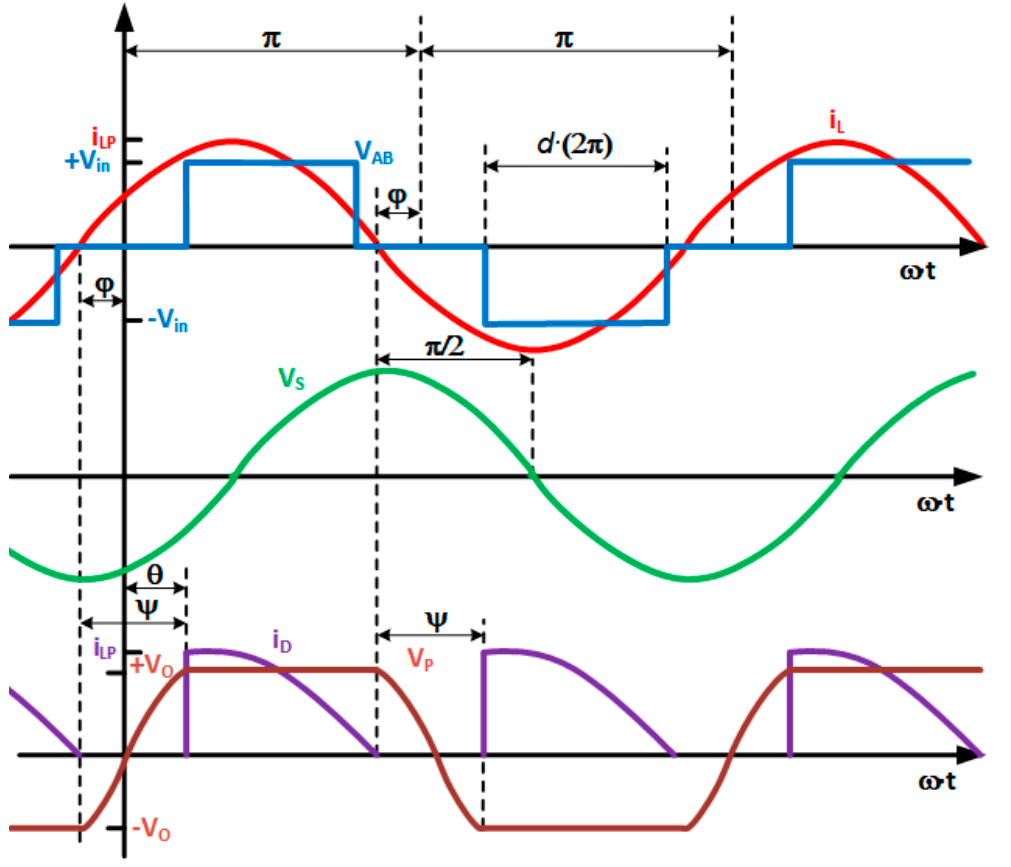
Figure 4. Main waveforms of the topology. V AB is the input voltage of the resonant tank. i LP is the current of the resonant tank. V S is the voltage of the series inductance. V P is the voltage of the parallel capacitor C P . i D is the current through the output diodes. ϕ is the delay between input voltage V AB and resonant current i LP .